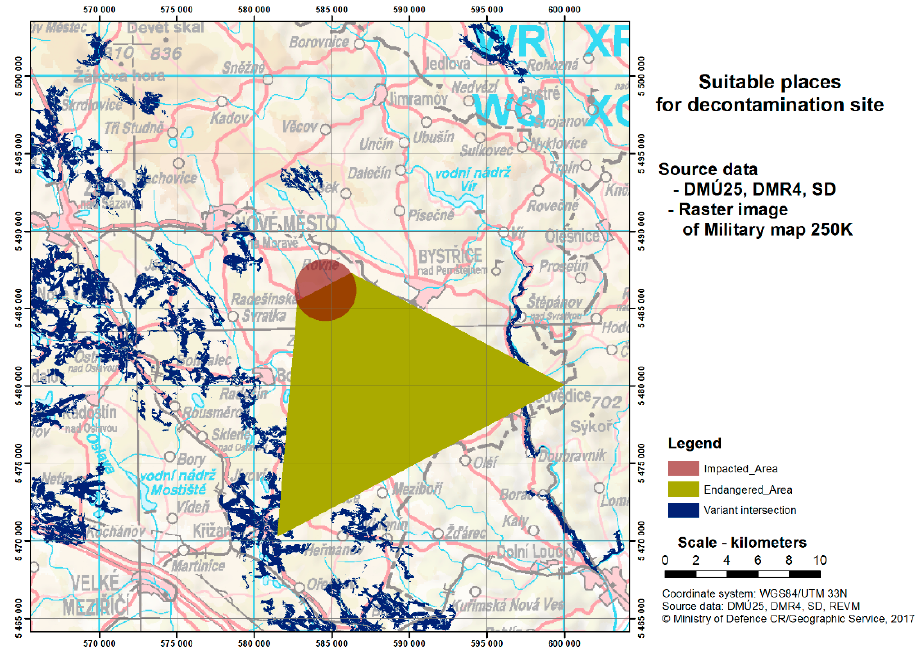
Figure 12. Intersection of all three researched variants for possible deployment of DS.